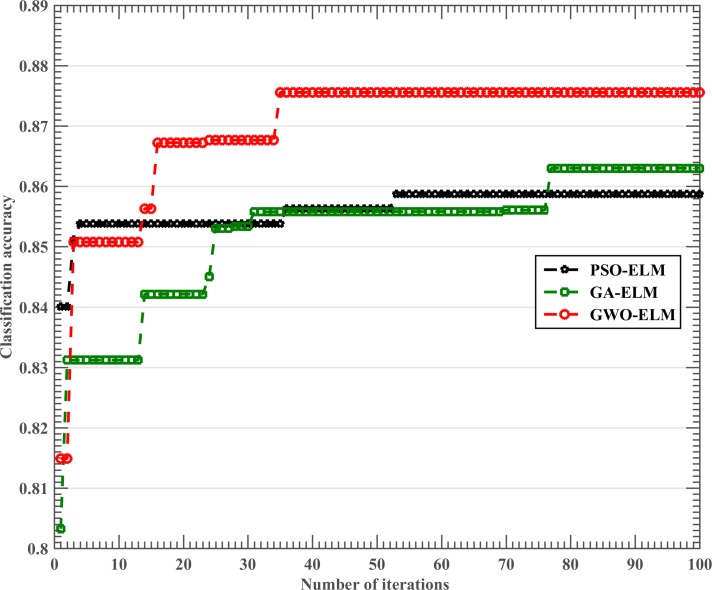
The mean result of the best fitness during the training stage in 10-fold CV procedure obtained by the three methods.